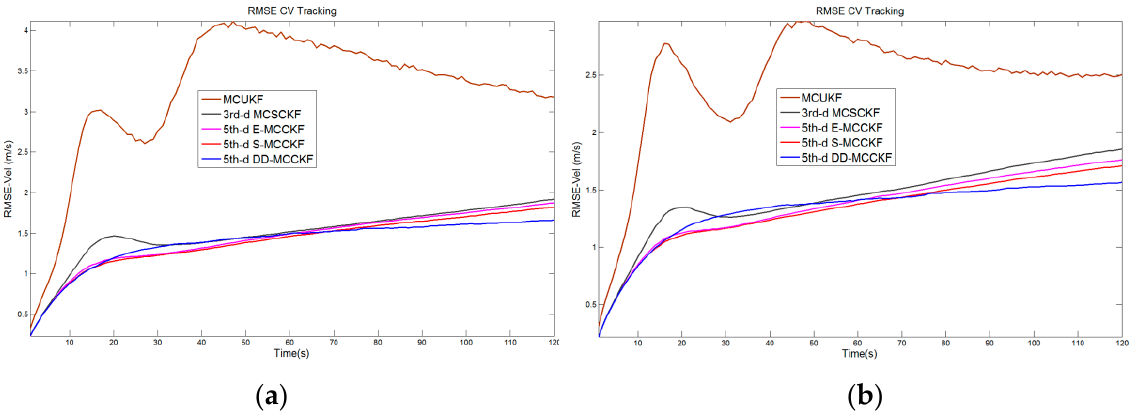
Figure 6. Velocity RMSEs of robust target-tracking algorithms under non-Gaussian noise conditions (( a ) is the result under Equation (61) and ( b ) is the result under Equation (62)). Table 3 shows the number of points and ARMSE of each algorithm in Experiment 2